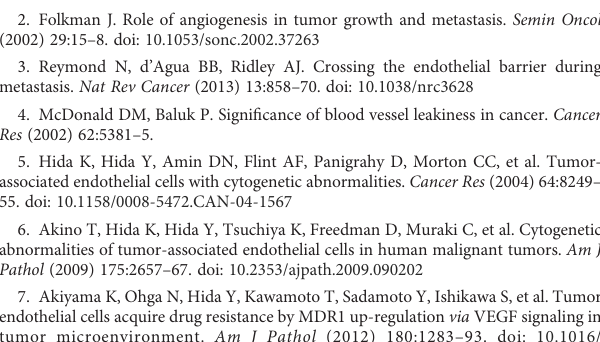
SUPPLEMENTARY FIGURE 1 EVcharacterization. (A) A375SM-EVswereobservedbyatransmissionelectron microscope.Scalebar:100nm. (B) TheparticlesizedistributionofA375SM-EVs was measured by dynamic light scattering. (C) The levels of HSP70 and cytochrome C in A375SM-EVs were determined by western blotting. SUPPLEMENTARY FIGURE 2 miR-1246 levels in miR-1246-knockdown tumor cells. miR-1246 levels in anti-miR-1246 A375SM cells (A) and EVs (B) were examined by qRT-PCR. Data are presented as mean ± SD; n = 3 real-time RT-PCR runs (*P < 0.0001 vs. control-miR-1246 A375SM, two-sided Student ’ s t-test). SUPPLEMENTARY FIGURE 3 ICAM-1inductionbytumor-EVundertheSTAT3inhibitor.ICAM-1mRNAlevels iniHMVECs treatedwithA375SM-EVswithor withouttheSTAT3inhibitor(S3I- 201) were examined by qRT-PCR (*P =0.0009 (Control vs. A375SM-EV), 0.0002 (A375SM-EV vs. S3I-201(10 m M) + A375SM-EV), 0.0048 (S3I-201 (10 m M) + A375SM-EV vs. S3I-201(50 m M) + A375SM-EV), one-way ANOVA, followed by a Tukey – Kramer multiple comparison tests). PBS was used as the control. Data are presented as mean ± SD; n = 4 real-time RT-PCR runs. SUPPLEMENTARY FIGURE 4 miR-1246 in EVs promotes the adhesion of high metastatic tumor cell to ECs, related to . (A) Representative fl uorescent images of adherent tdTomato-luc2- expressing A375SM cells to iHMVEC monolayer treated with A375SM-EVs. The lower panel shows an enlarged image of the regions marked with yellow rectangles. PBS was used as the control. (B) The number of tdTomato-luc2- expressing A375SM cells was counted. Data are presented as mean ± SD; n = 5 fi elds. Scale bar:100 µm(*P<0.0001vs. control, two-sided Student ’ st-test). (C) Representative fl uorescent images of adherent tdTomato-luc2-expressing A375SM cells to miR-1246 transfected iHMVEC monolayer. The lower panel shows an enlarged image of the regions marked with yellow rectangles. microRNA Mimic Negative Control was used as the control. (D) The number of tdTomato-luc2-expressing A375SM cells was counted. Data are presented as mean ± SD; n = 5 fi elds. Scale bar: 100 µm (*P < 0.0001 vs. control, two-sided Student ’ s t-test). (E) Representative fl uorescent images of adherent tdTomato- luc2-expressingA375SMcellstoiHMVECmonolayertreatedwithAnti-miR-1246 A375SM-EVs. The lower panel shows an enlarged image of the regions marked with yellow rectangles. (F) The number of tdTomato-luc2-expressing A375SM cells was counted. Data are presented as mean ± SD; n = 5 fi elds. Scalebar:100 µm (*P < 0.0001 vs. control-miR A375SM-EVs, two-sided Student ’ s